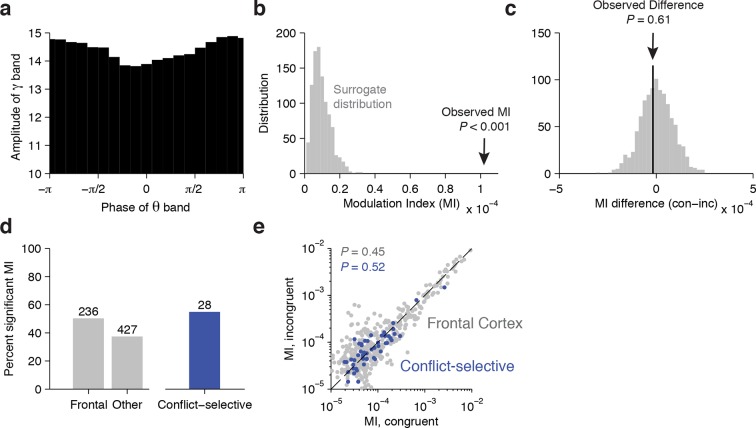
Cross-frequency coupling analyses.For the anterior cingulate cortex electrode in Figure 2: (A) Phase-amplitude distribution during the Stroop task for the example electrode shown in Figure 2 (see Materials and methods for calculation of cross-frequency coupling). (B) The observed Modulation Index (MI, black arrow) is significantly greater than the surrogate distribution generated by adding a lag between the phase and amplitude measurements, demonstrating that the amplitude of the gamma band is strongly coupled to the phase of the theta band. (C) During the Stroop task, the difference in Modulation Index between congruent and incongruent trials (black arrow) was not significantly different from 0 (P = 0.61). The null distribution (gray bars) was generated by randomly permuting the congruent and incongruent labels. Across the population of electrodes: (D) The percent of total electrodes in each region (Frontal cortex or non-frontal cortex) that had significant phase-amplitude coupling. Shown on the right is the percentage of the n = 51 conflict selective electrodes that showed significant coupling. (E) The MI of congruent compared to incongruent trials for all Frontal cortex electrodes (gray dots) and the subset that were conflict-selective in the gamma band (blue dots). For both groups, there was no significant difference in the MI between congruent and incongruent trials (Frontal Cortex, P = 0.45; Conflict-selective, P = 0.52; signed-rank test). For this comparison, the number of congruent and incongruent trials was equalized before computing the MI.